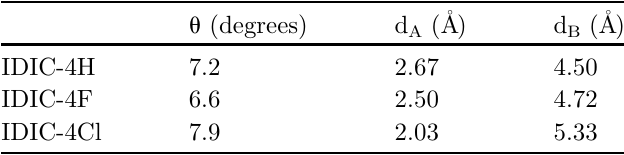
Table 4. Dihedral angles ( u ) between IDT-IC planes and distances between the neighboring IDT